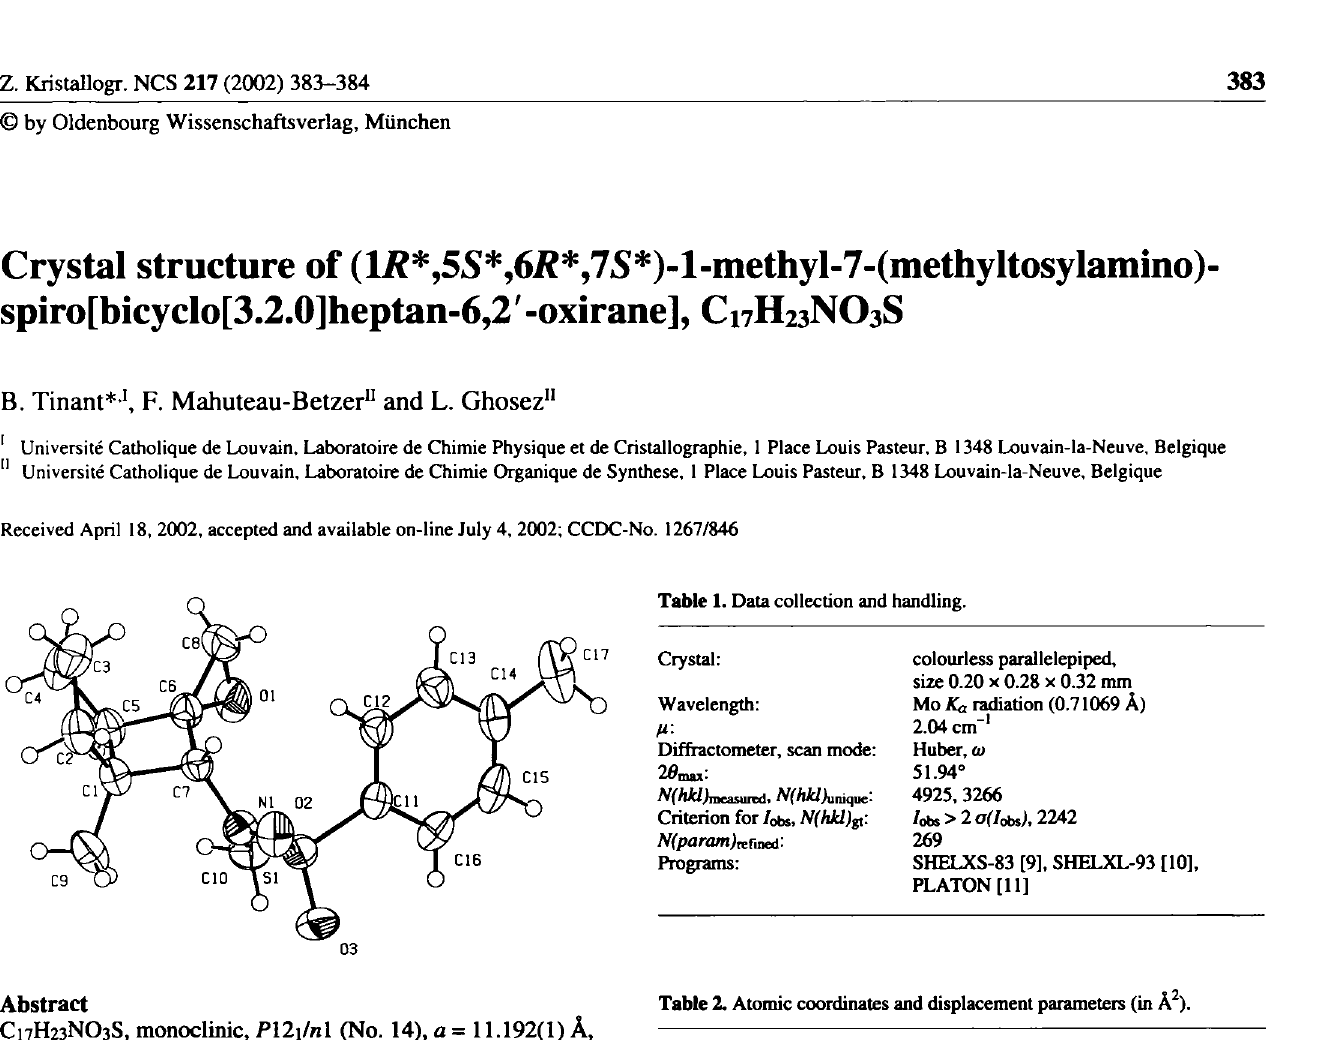
Table 2. Atomic coordinates and displacement parameters (in Â 2